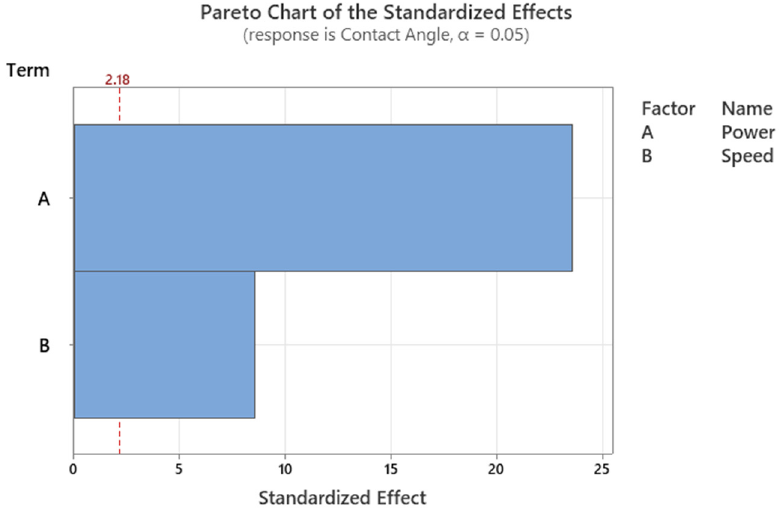
Figure 5. Pareto chart of the standardized effect of laser power and scan speed on contact angle .